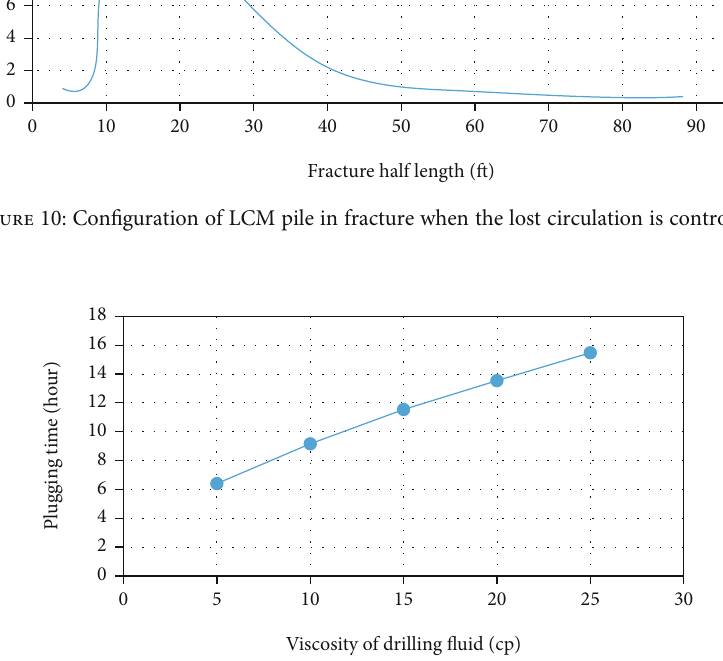
Figure 11: Plugging time versus viscosity of drilling fl uid.